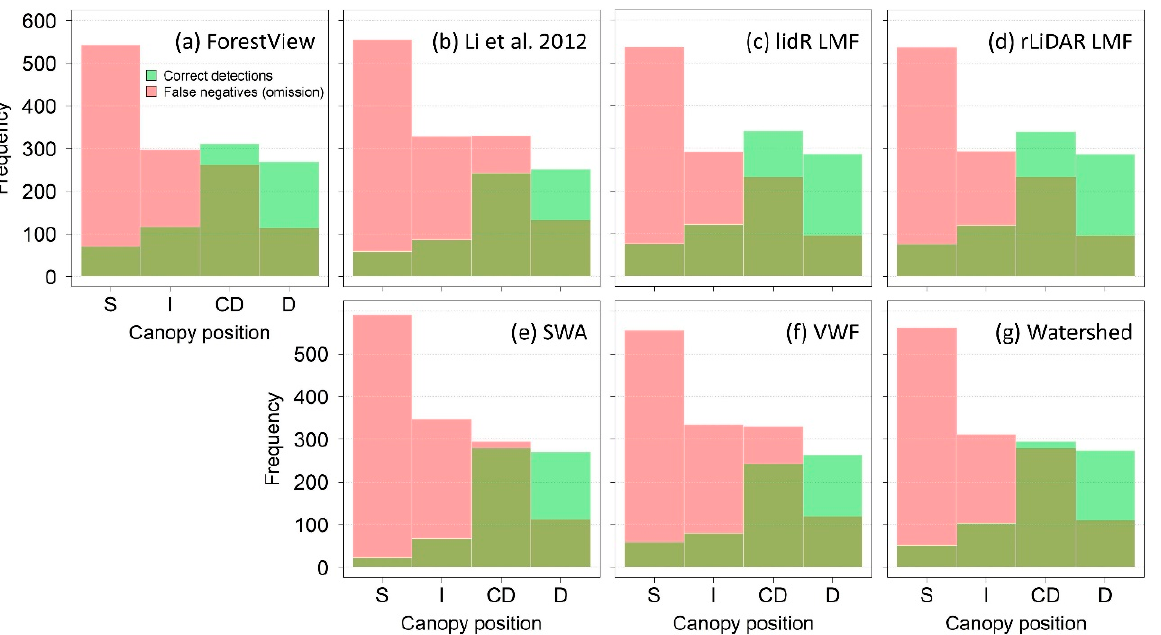
Figure 3. Correct detection and false negative (omissions) distributions by canopy position for the seven most accurate ITD method approaches derived from the 22 ppm 2 ALS dataset (highlighted in Table 4). Dark-green coloration indicates where the two distributions overlap. Canopy positions are as follows: S = suppressed, I = intermediate, CD = codominant, D = dominant. The method shown in (b) refers to [19].